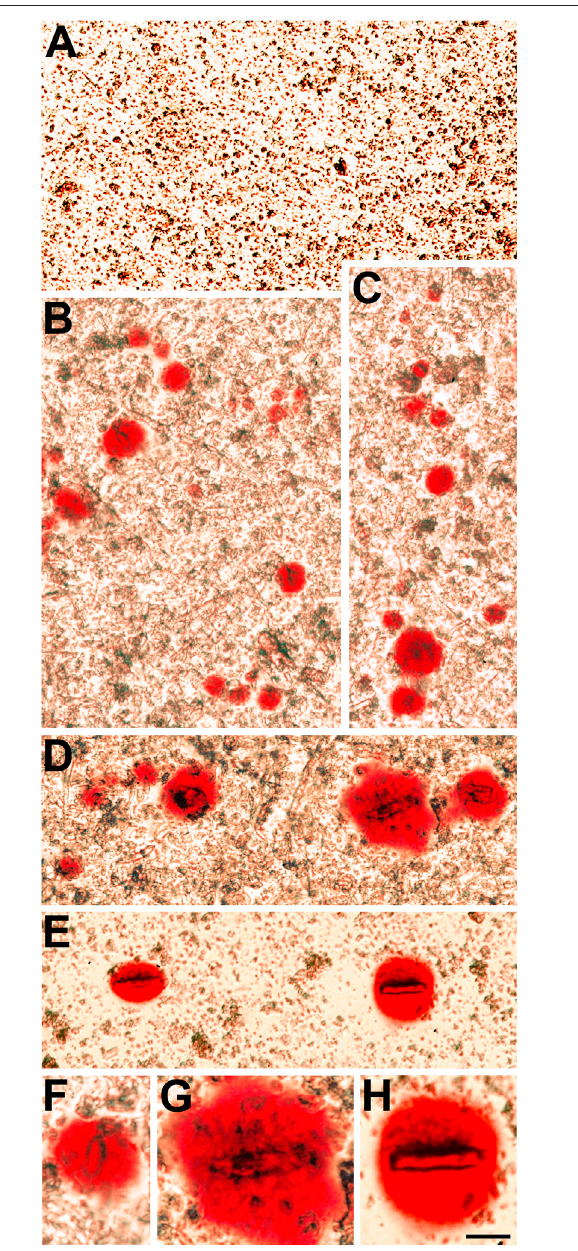
FIGURE 4 | The insoluble fraction of homozygous Cx50D47A lenses containsAlizarinred-stainedcrystals. (A) ImageshowsthelackofAlizarinred- stained material in the lens insoluble fraction from a 93-day-old wild-type Cx50D47A female mouse. (B − E) Images show several Alizarin red- stained crystals present in the insoluble fraction of Cx50D47A homozygous lenses from a 60-day-old female mouse (E) and a 93-day-old male mouse (B – D) . (F − H) Higher magni fi cation images of selected Alizarin red-stained crystals from panels (B,D,E) . The images were modi fi ed to decrease the reddish background from the Alizarin red solution used to resuspend the insolublefraction.Thescalebarrepresents54 µminpanels (A − E) ,and27 µm in panels (F − H)